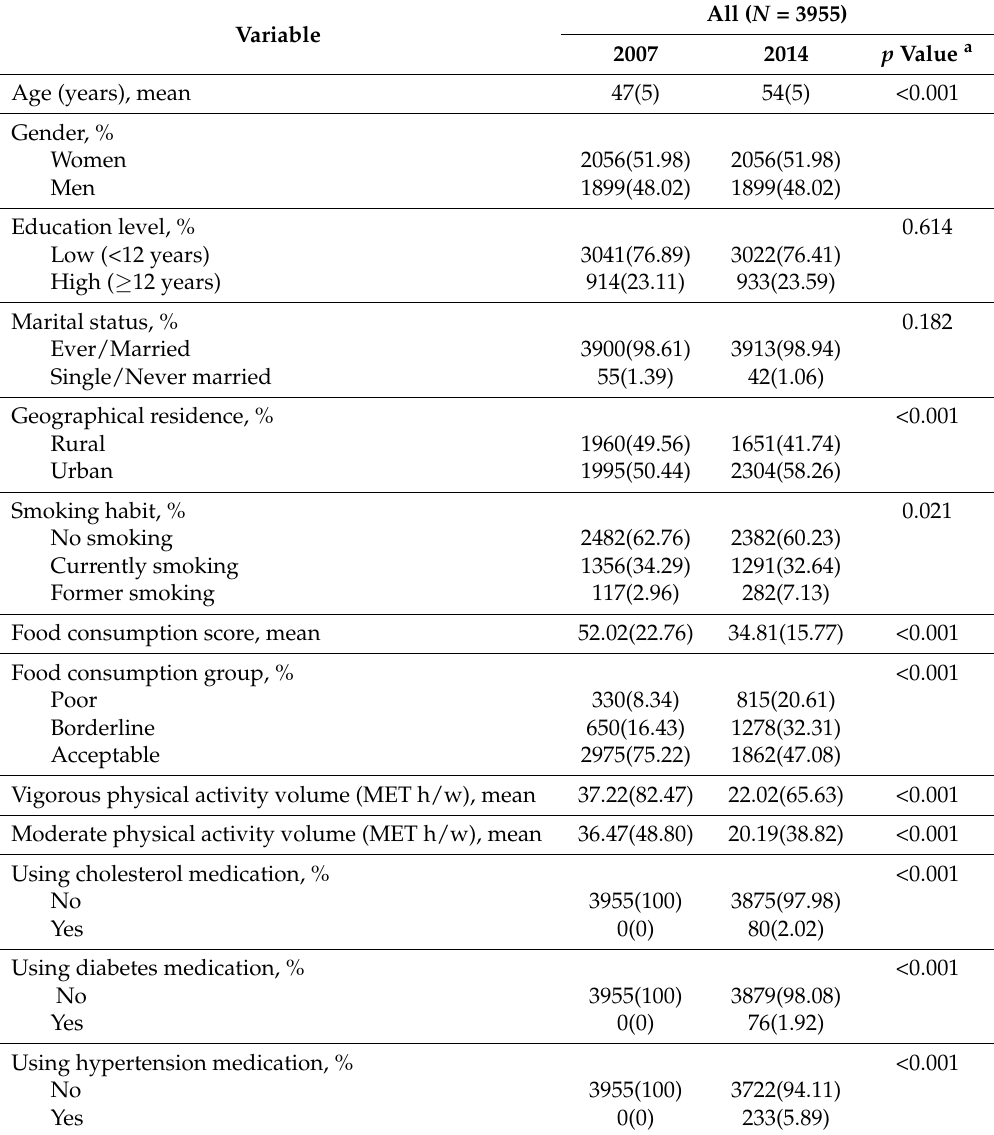
Table 1. Characteristic of study